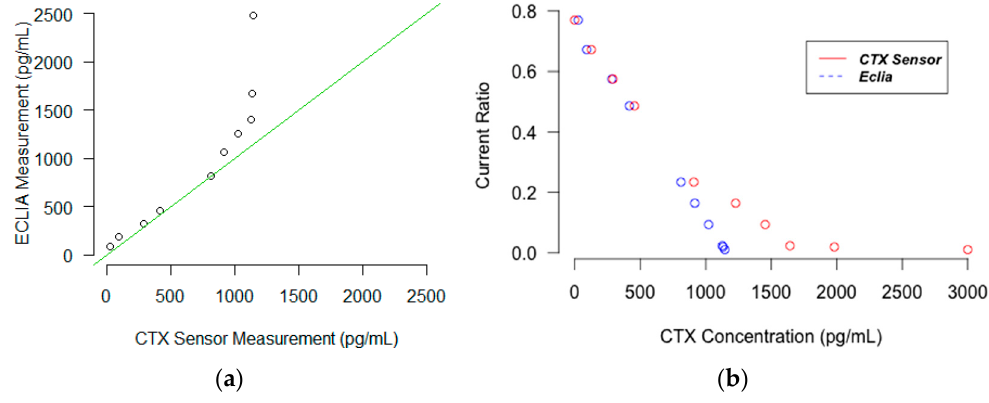
Figure 4. Plot displaying ( a ) the correlation between Osteokit and ECLIA results for CTX measurement (b) chronoamperometric response for CTX measurement using Osteokit and ECLIA.